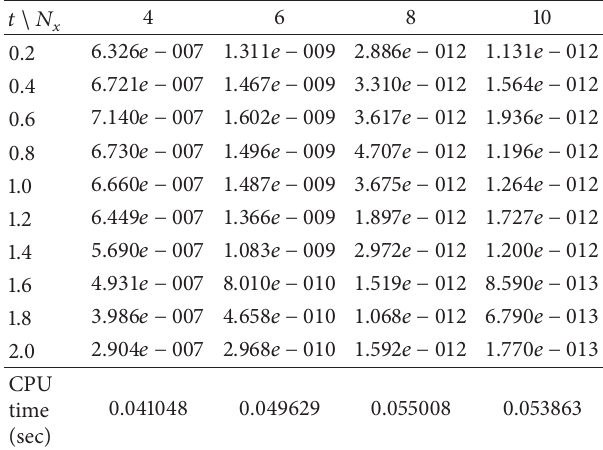
Table 8: Maximum errors 𝐸 𝑁 for the Burgers-Fisher equation when = 10 . 𝛼 = 1 using 𝑁 𝑡 𝑡 \ 𝑁 𝑥 4 6 0.2